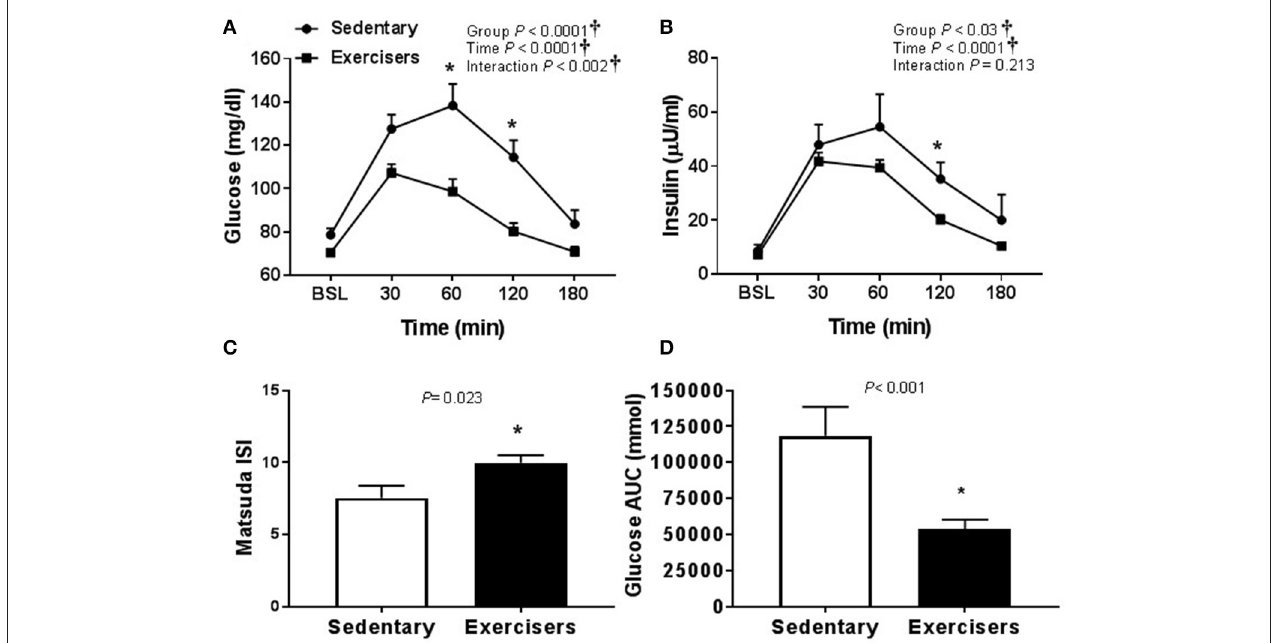
FIGURE 5 | Glucose homeostatic responses to a 75g glucose high sugar meal (HSM) at baseline, and 30, 60, 120, and 180min post-ingestion in sedentary participants ( n = 11) and exercisers ( n = 33). (A) Blood glucose response over 180min. (B) Serum insulin levels over 180min. (C) Matsuda insulin sensitivity index (ISI) and (D) Glucose are under the curve (AUC) over the 180min postprandial period. All data presented as mean ± SEM. † Indicates significant main or interaction effect ( P < 0.05). *Indicates significant difference between sedentary participants and exercisers (adjusted P < 0.05; Sidak-Bonferroni adjustment for ANOVA multiple comparisons).